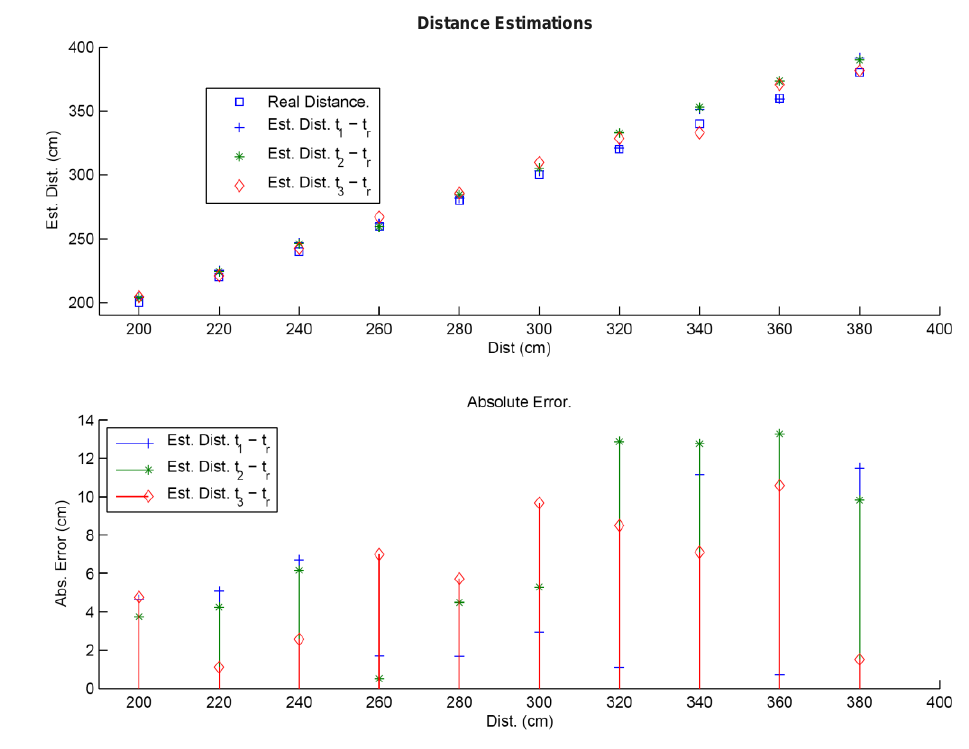
Figure 3. Representative distance estimations and absolute error for Experiment 1.